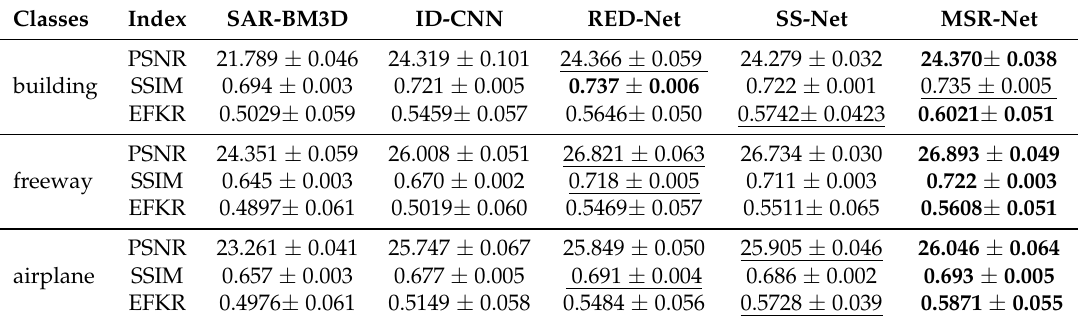
The bold number represents the optimal value in each row, while the underlined number denotes the suboptimal value in each